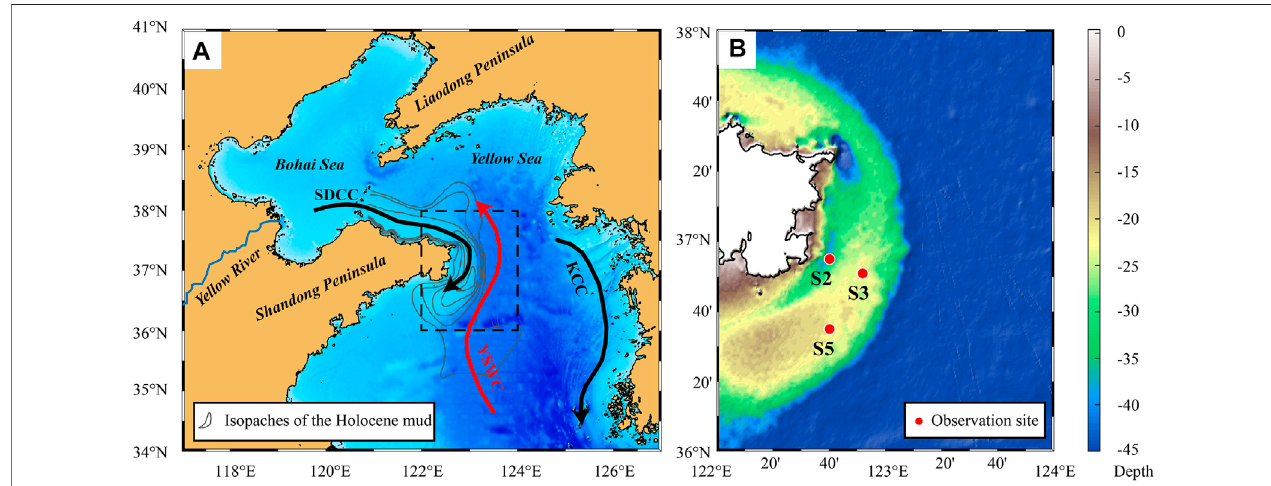
FIGURE 1 | (A) Topography and currents of the Bohai and Yellow seas. The isopaches of the muddy area were from Yang and Liu (2007), and the currents were based on Bian et al. (2013). These currents are theShandong Coastal Current (SDCC), the Yellow Sea Warm Current (YSWC),and the Korea Coastal Current (KCC) (B) The location of the observation sites.